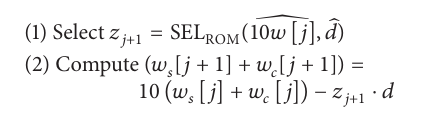
Algorithm 3: Pseudocode for the type2 digit